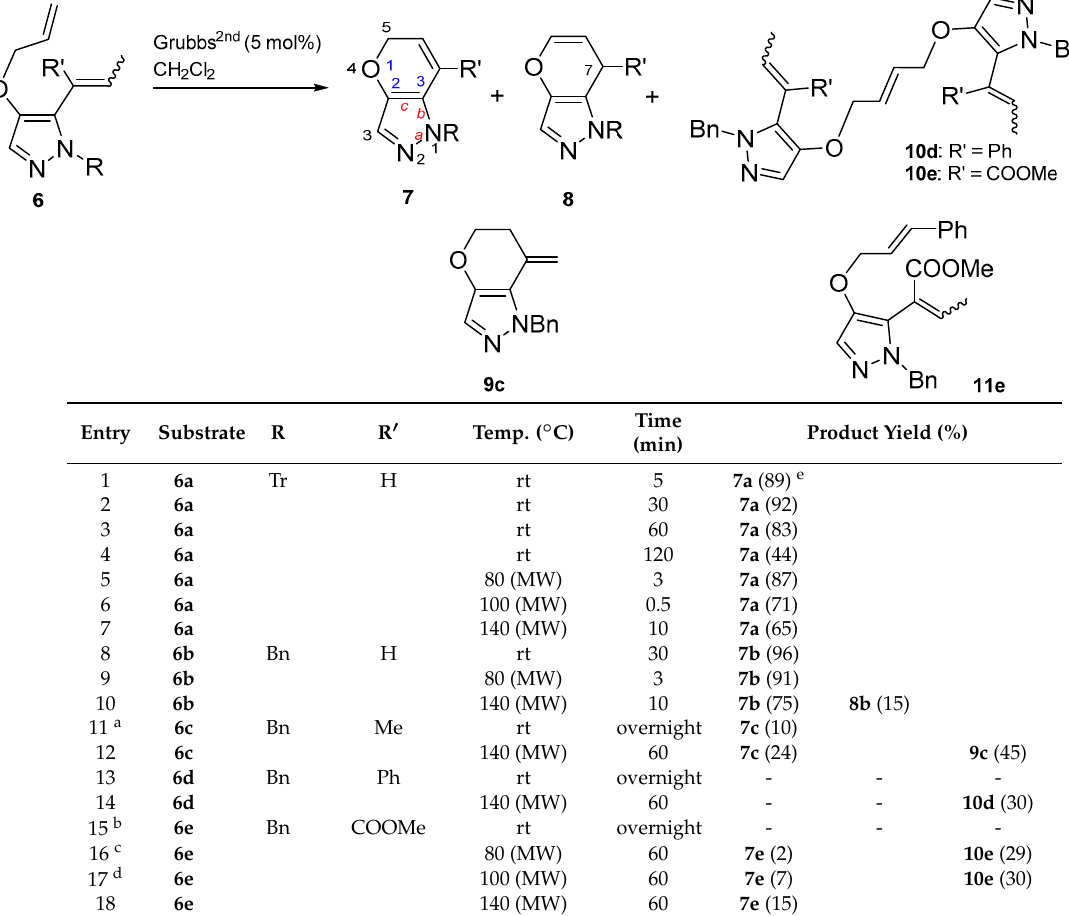
Table 1. Ring-closing metathesis (RCM) of 5-allyl-4-allyloxy-1 H -pyrazoles.